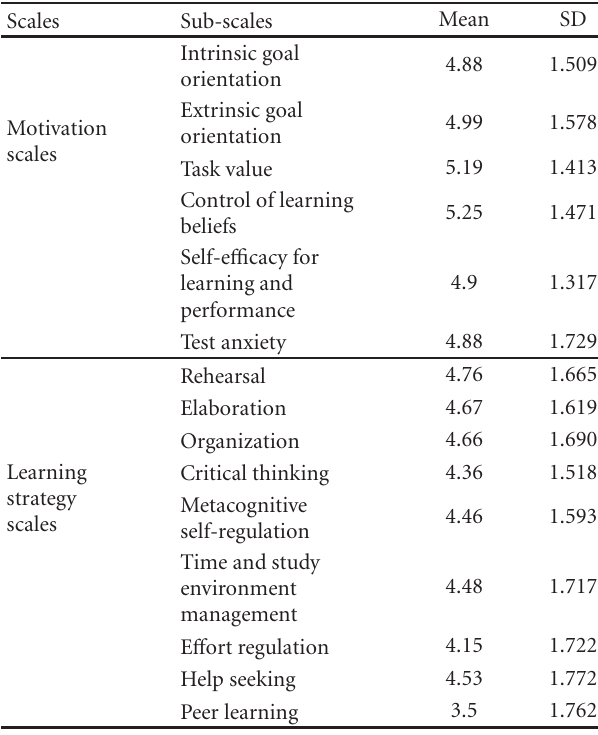
Table 1: Descriptive statistics of motivated strategies for learning questionnaire (MSLQ) for Korean American students 1 .